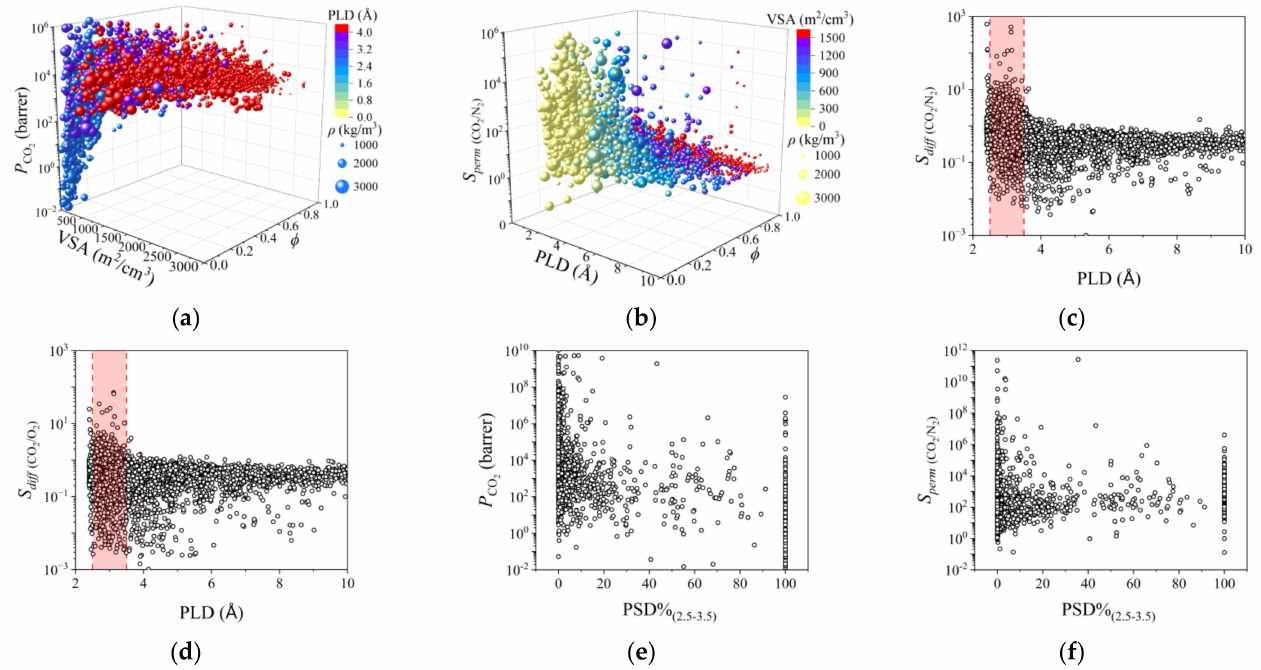
Figure 1. Structures–performance relationship studied by univariate analysis. ( a ) P CO –VSA, φ , 2 PLD, and ρ ; ( b ) S perm (CO –VSA, φ , PLD, and ρ ; ( c ) S diff (CO –PLD; ( d ) S diff (CO –PLD; 2 /N 2 ) 2 /N 2 ) 2 /O 2 ) ( e ) P CO –PSD% (2.5 – 3.5) ; ( f ) S perm (CO –PSD% (2.5 – 3.5) . In ( a ), the colors of balls represent PLD and 2 2 /N 2 ) the sizes of ball represent ρ of MOFMs. In ( b ), the colors of balls represent the VSA and the sizes of ball represent ρ of